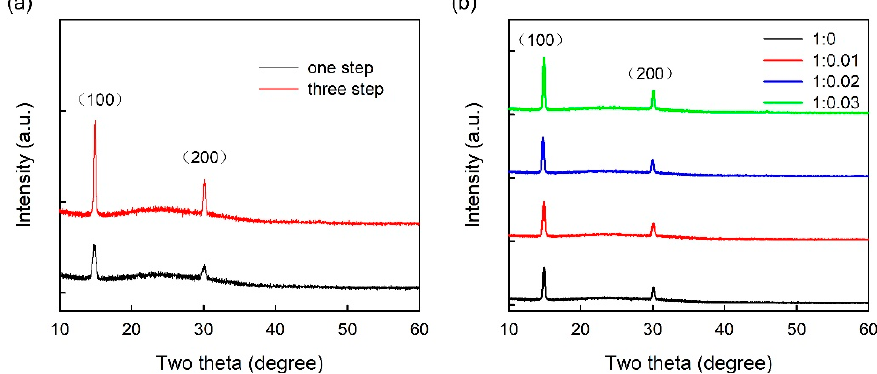
Figure 3. XRD patterns of ( a ) one-step and three-step coated CH 3 NH 3 PbBr 3 films on the pure PEDOT:PSS film, ( b ) three-step coated CH 3 NH 3 PbBr 3 films on the pure PEDOT:PSS film and PEDOT:PSS/MoO 3 -ammonia composite HTLs with different MoO 3 ratios. The XRD patters were shifted vertically for clarity.